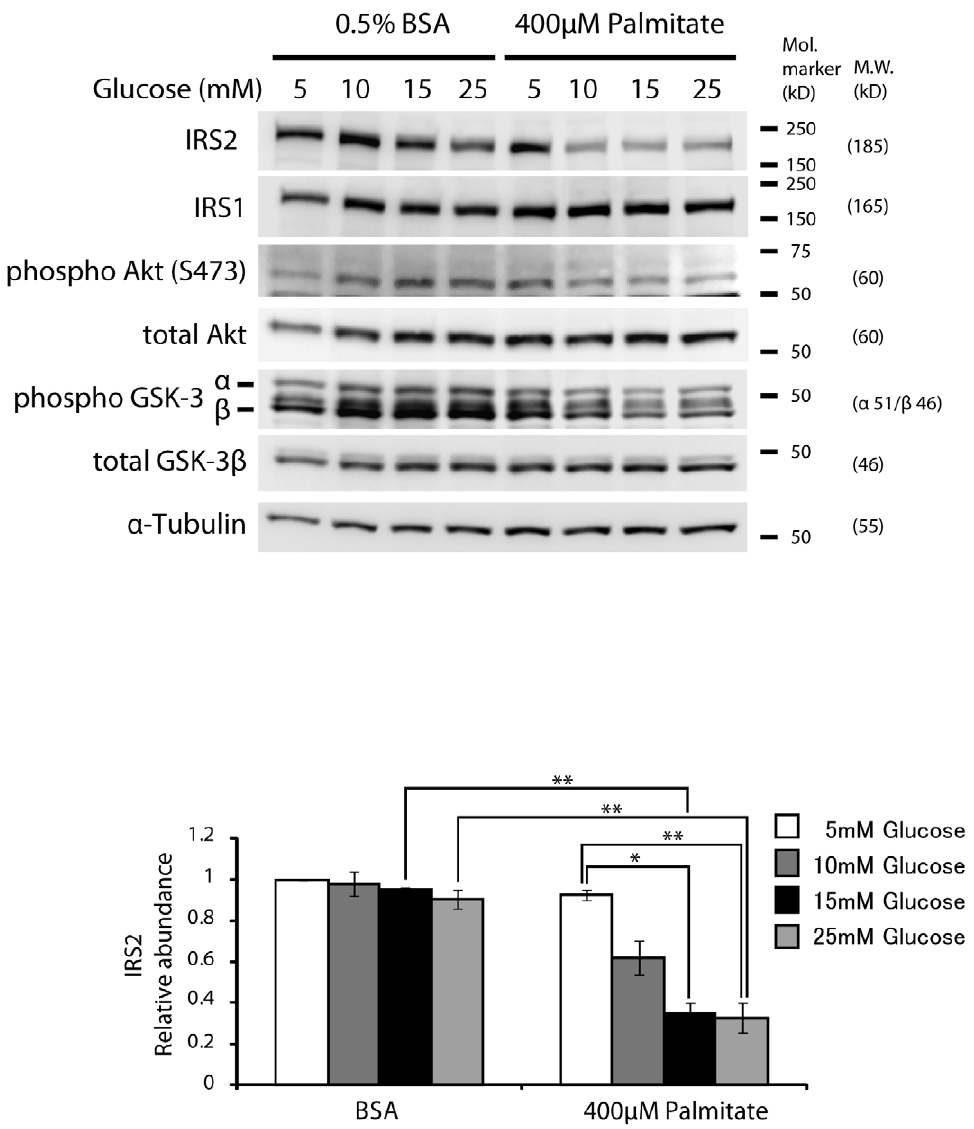
Figure 2. Glucose and palmitate potentiate to reduce insulin signaling. MIN6 cells were treated with either control 0.5% BSA (four lanes on left) or 400 m M palmitate + 0.5% BSA (four lanes on right) at a concentration of 5, 10, 15, 25 mM glucose for 24-h. Total cell lysates were obtained and were subjected to Western blot analysis with antibodies to the indicated proteins. Protein level of IRS2 was normalized over a -Tubulin. The representative results of three individual experiments are shown. The results for IRS2 are graphically illustrated, data are expressed as means 6 S.E.M. *p , 0.05, **p , 0.01.